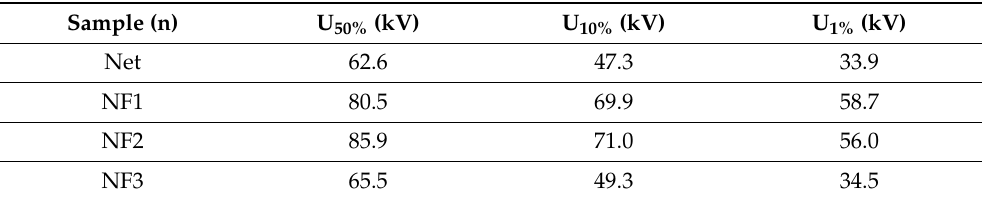
Figure 8. Probability density plot of the BD events with conformity to the Weibull line. From this plot, the BDV at failure probabilities of 1%, 10% and 50% are calculated and presented in Table 4. The choice of these levels corresponds to their importance for the operation of the HV equipment. U 50% is an indication of the expected BDV, U 10% provides an indication of the lowest possible BDV, and therefore provides information on the reliability of the insulation [11,12,22,34,35,37,38], while U 1% corresponds to the limit of voltage for safety and continuous operation of the transformer [11,22], a critical parameter for the insulation coordination of power systems under lightning and surge events [45,46]. Table 4. Withstand voltages at 1, 10 and 50% failure probability levels with fitting to the Weibull